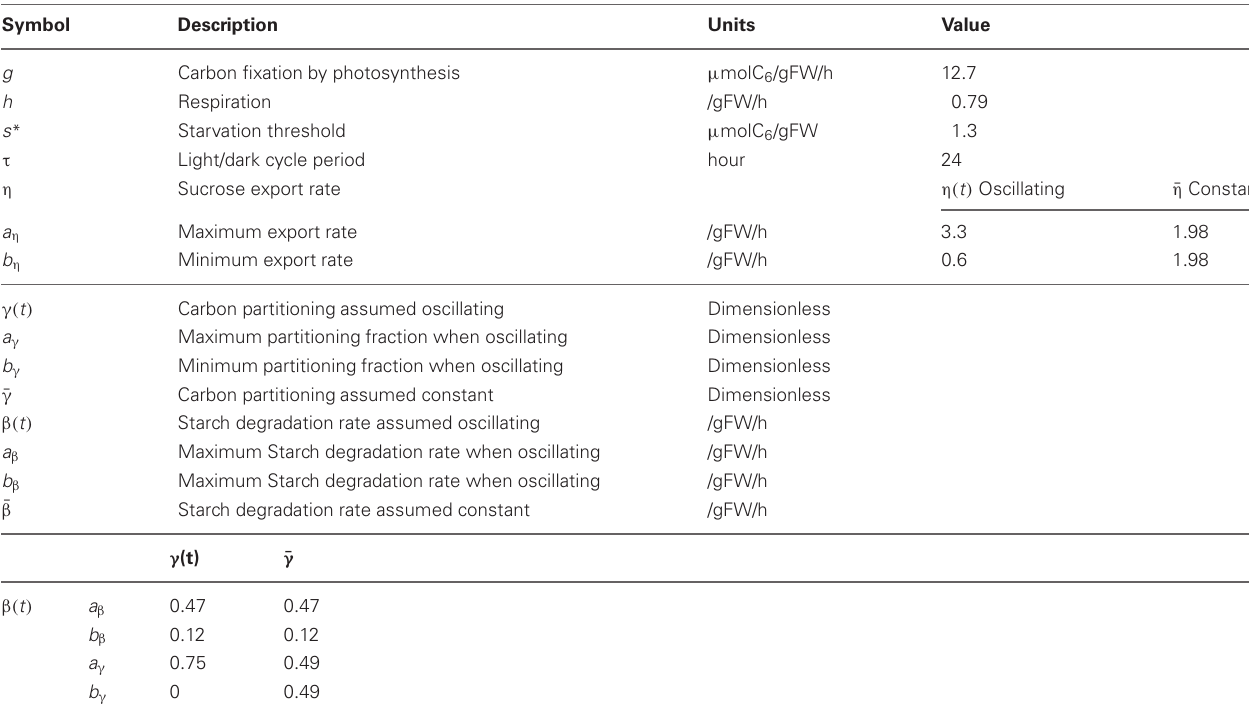
Table A1 | Parameter